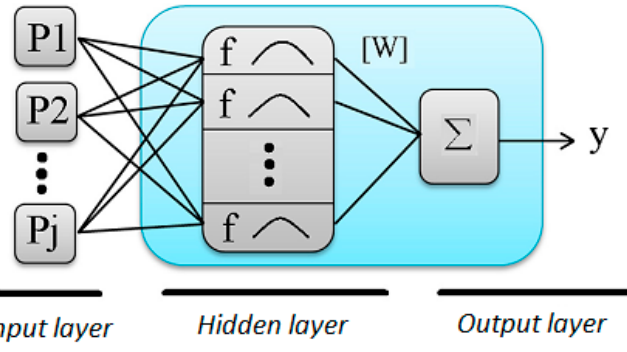
Figure 1. Schematic of a RBF network [31].